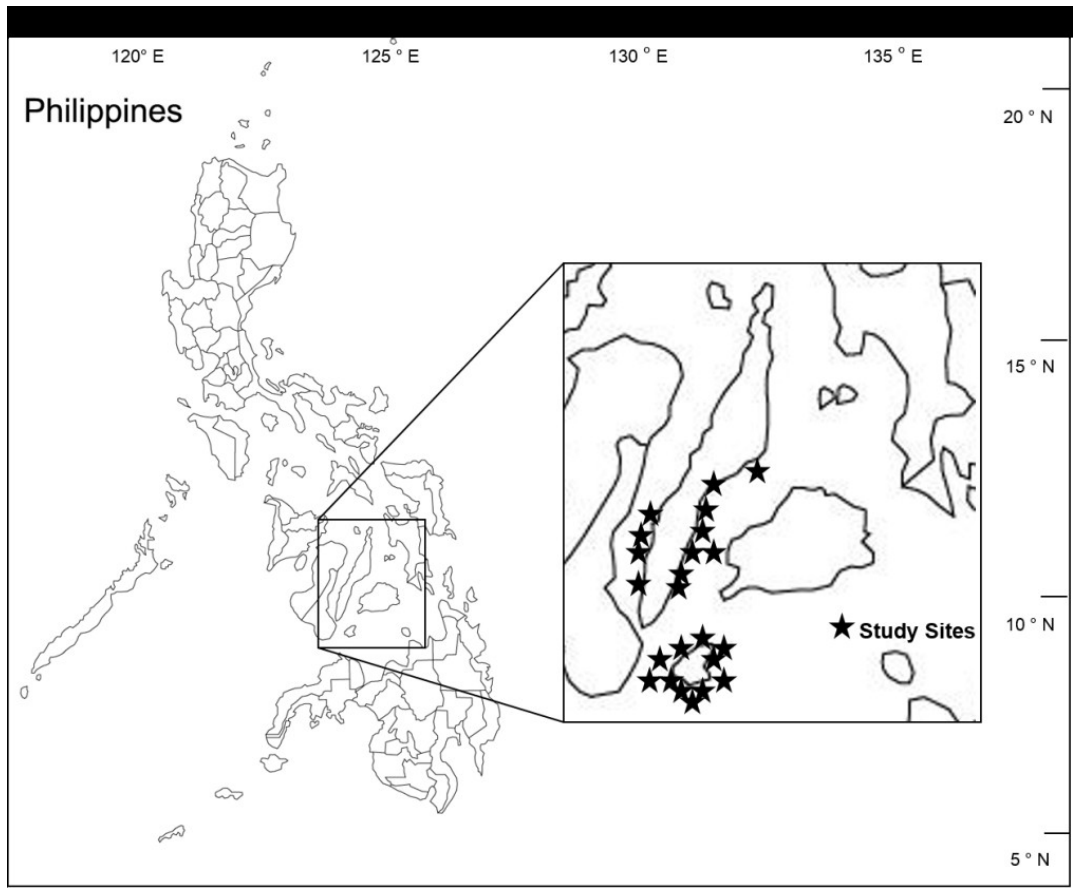
Figure 1. The location of the 23 marine protected areas (MPAs)/fished reef pair sites in Cebu and Siquijor Provinces,